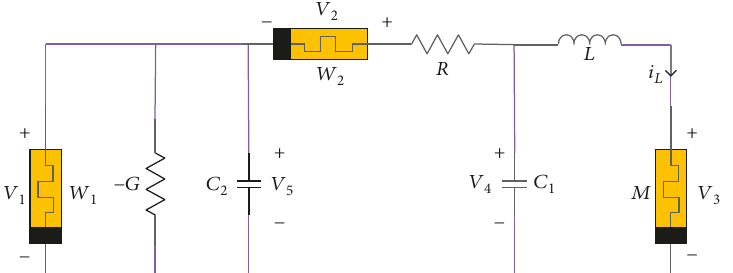
Figure 3: Circuit model based on memristors.